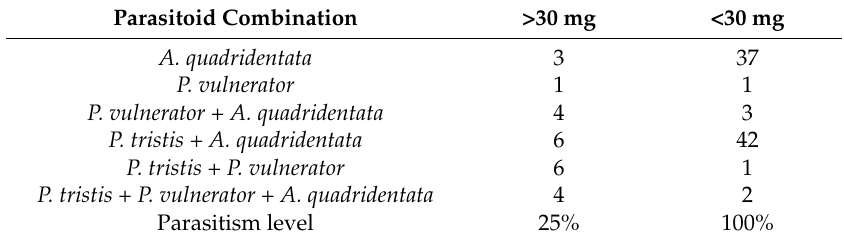
Table 5. DNA detection of parasitoid assemblage within 184 codling moth caterpillars collected in an apple orchard (123 out of 184 caterpillars were left to emerge). Estimates of the parasitism levels were based on the ratio of positive PCR for any parasitoids on the total number of collected codling moth caterpillars (97 were large, >30 mg, and 86 were small caterpillars, <30 mg, respectively). Parasitoid Combination >30